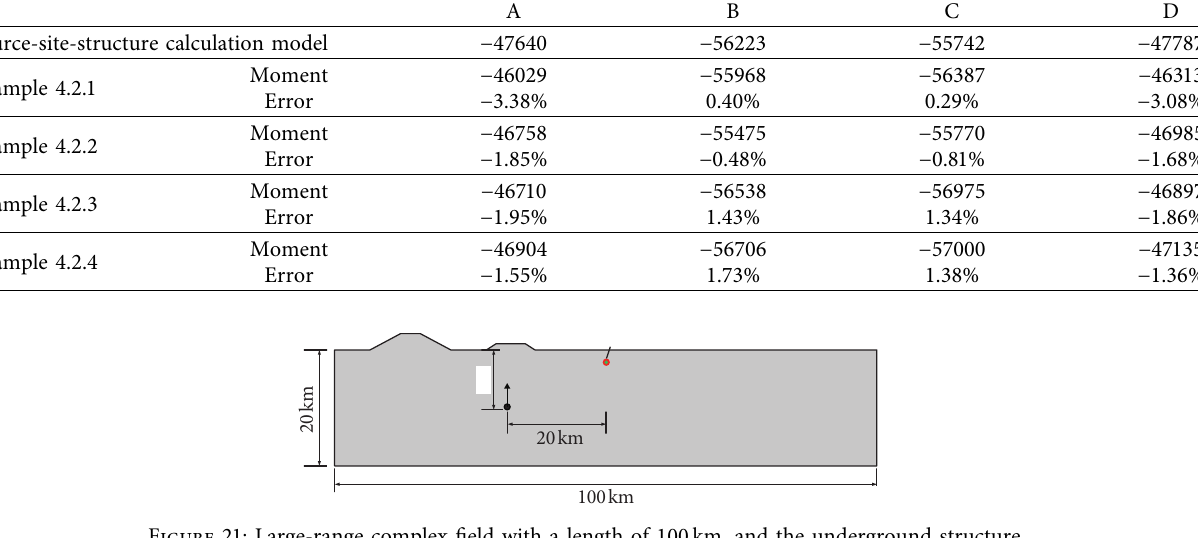
Table 1: Maximum bending moments values and errors of the observed sections in 4.2.1–4.2.4 (N · m).